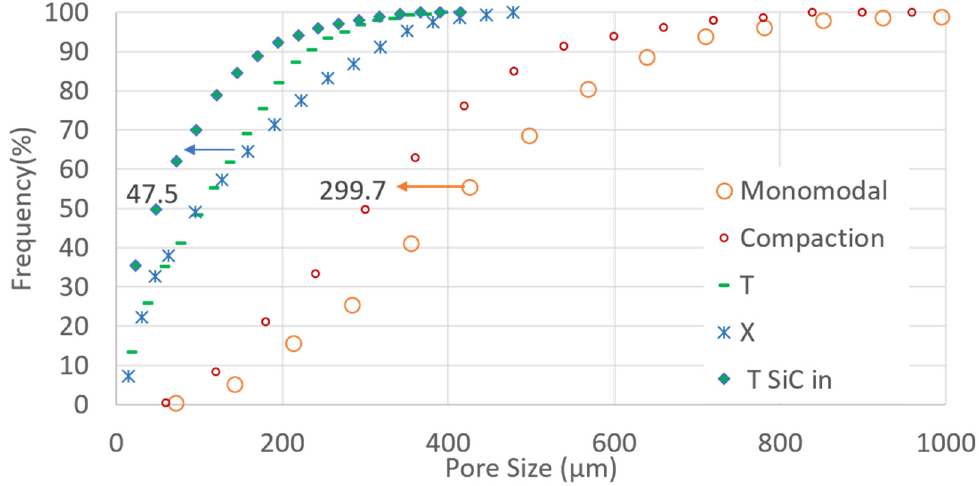
Figure 2. Pore size distribution determined by X-ray tomography, compaction, combining grain size, binding, and binding with SiC addition contribute to decreasing pore size. Table 2. Inter-Particle pores and Superinsulating Aerogel Particles, average sizes measured with a 3D grains growth procedure and X-ray tomography.